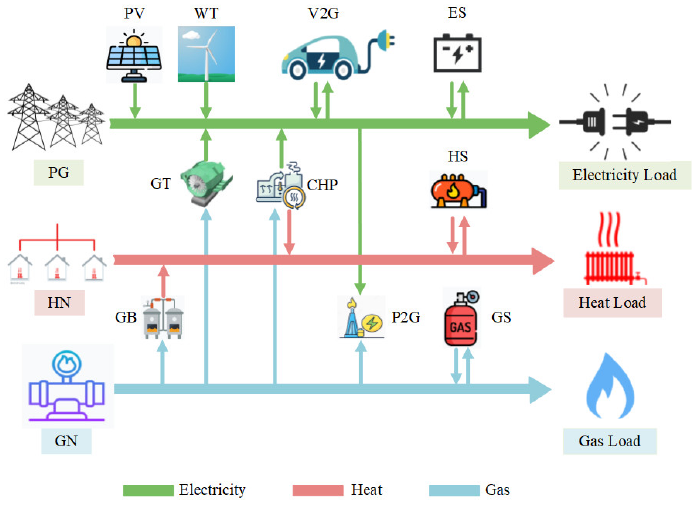
Figure 1. The structure of MES.